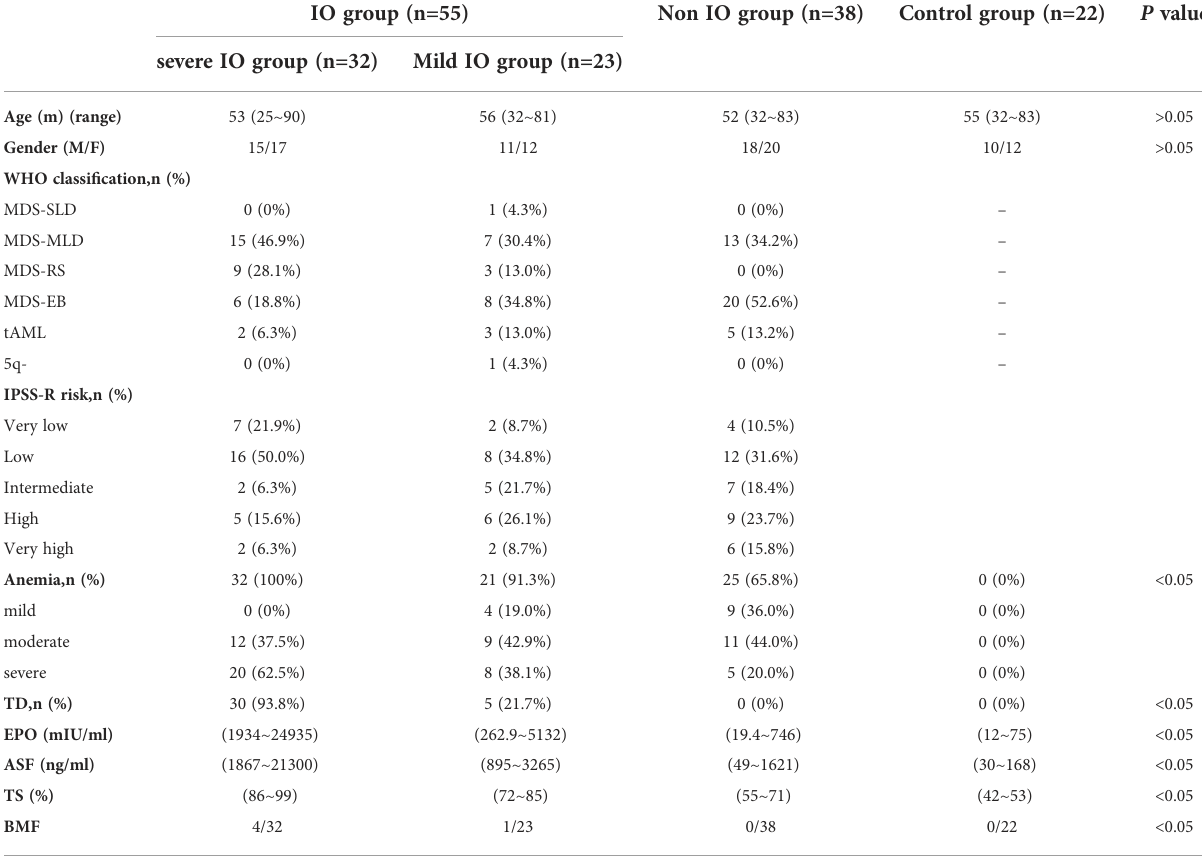
TABLE 1 General conditions of patients in MDS and control